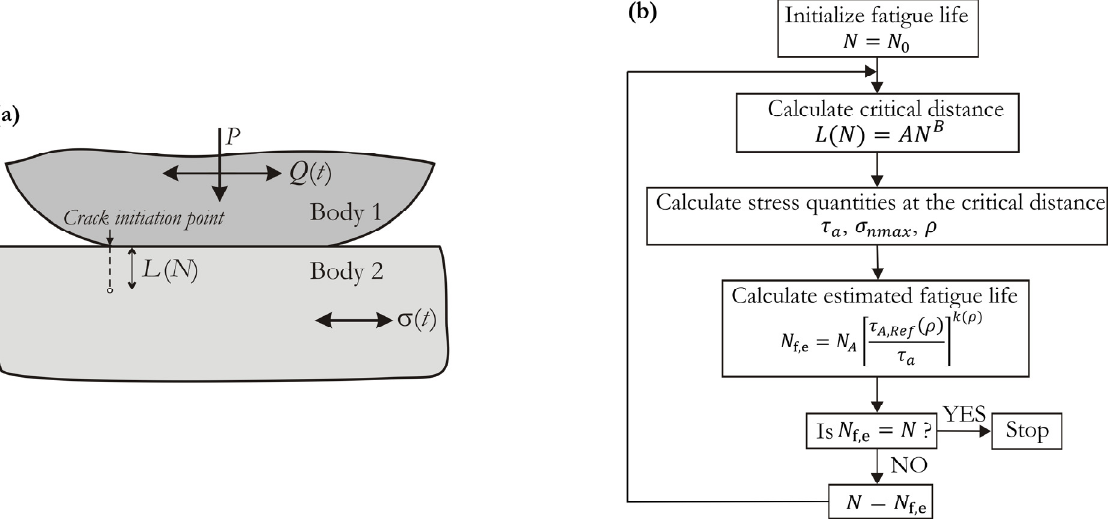
Figure 4: Procedure to estimate fretting fatigue life: (a) location of the critical distance and (b) flowchart of the iterative procedure for life estimation.